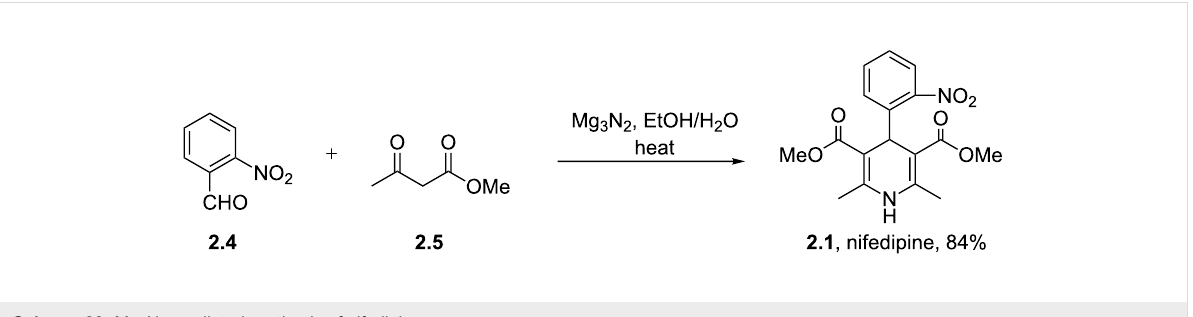
Scheme 23: Mg 3 N 2 -mediated synthesis of